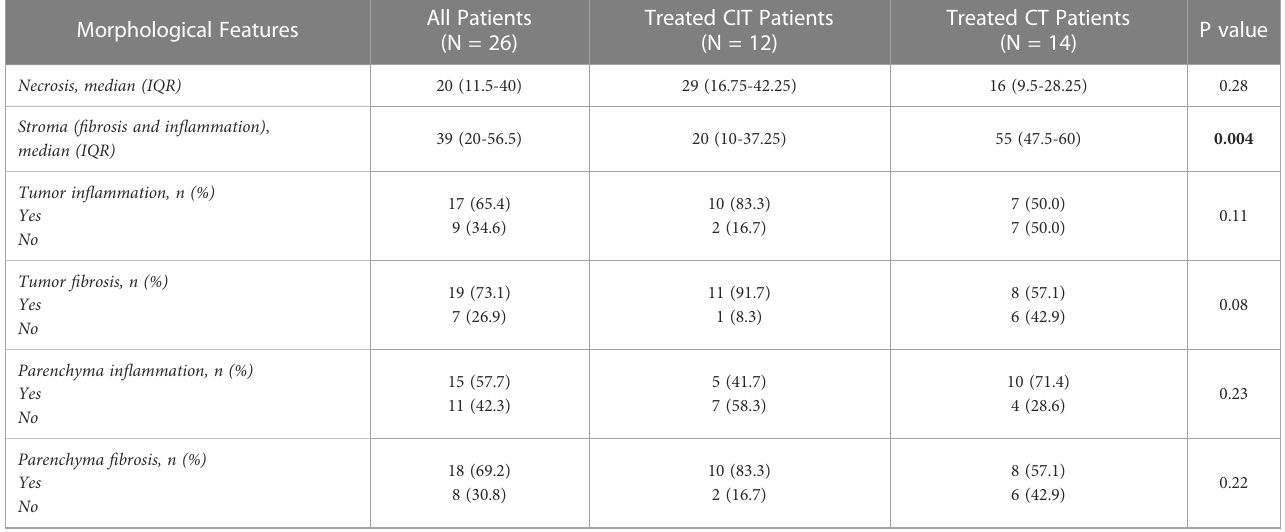
TABLE 2 Morphological characteristics of tumors after neoadjvant